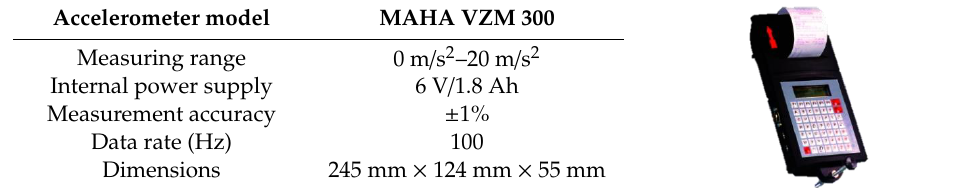
Table 2. Technical information about the High-Speed Camera used.